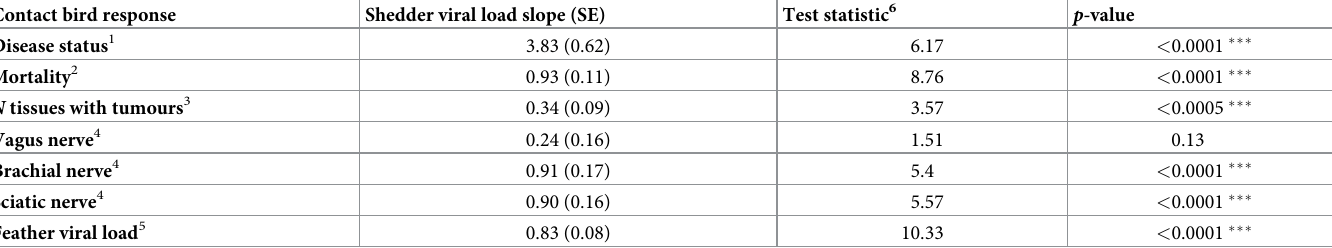
Table 2. Effects of shedder FVL on contact bird disease symptoms and feather viral load, for a model also including contact sex and shedder DPI but not including shedder vaccination status. Full results in S1 Table.